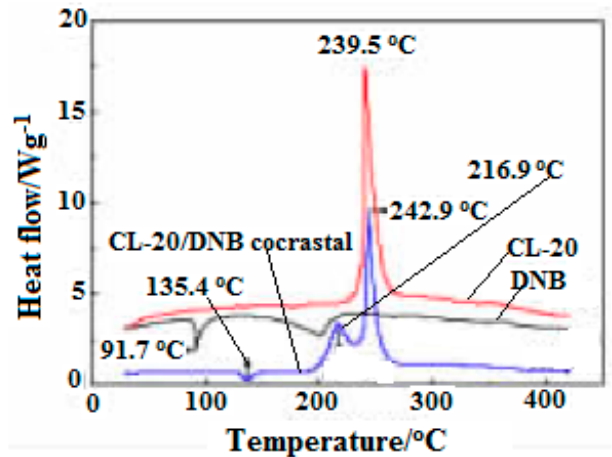
Figure 17. DSC curves of CL-20, DNB and CL-20 / DNB cocryatal [5], with permission from Chinese Journal of Energetic Materials, 2013.